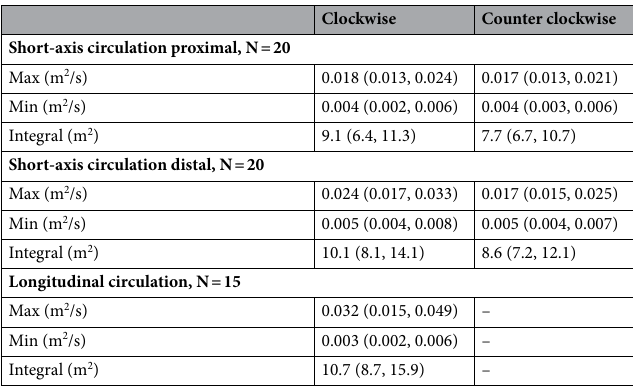
Table 2. Circulation in the main pulmonary artery was derived from 4D flow MRI. The Max and Integral values for clockwise short-axis vorticity were greater than those for counterclockwise circulation. Continuous variables are expressed as medians plus interquartile range (lower, upper).